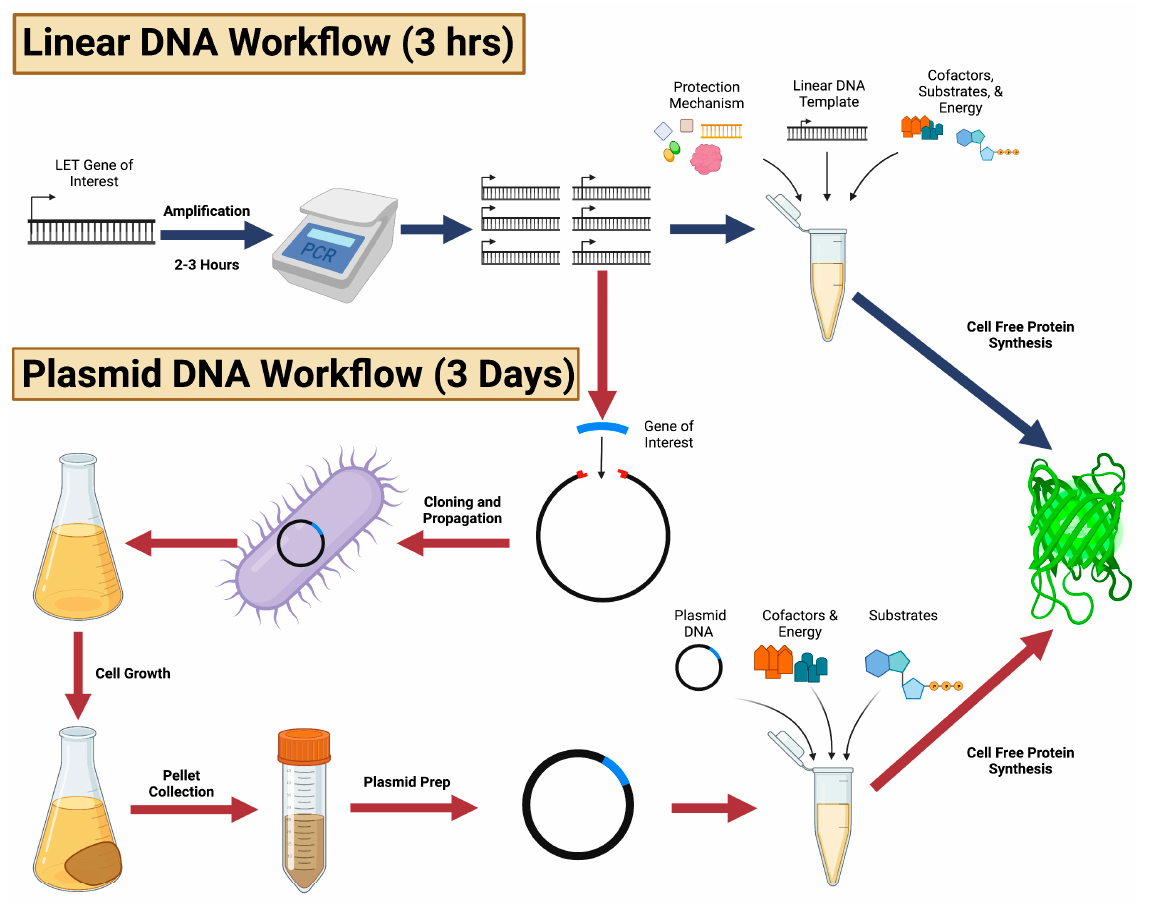
Figure 1. Complete workflow highlighting the major steps involved in template preparation and cell-free protein synthesis for both linear expression template (LET) DNA and plasmid DNA. Figure created with BioRender.com.